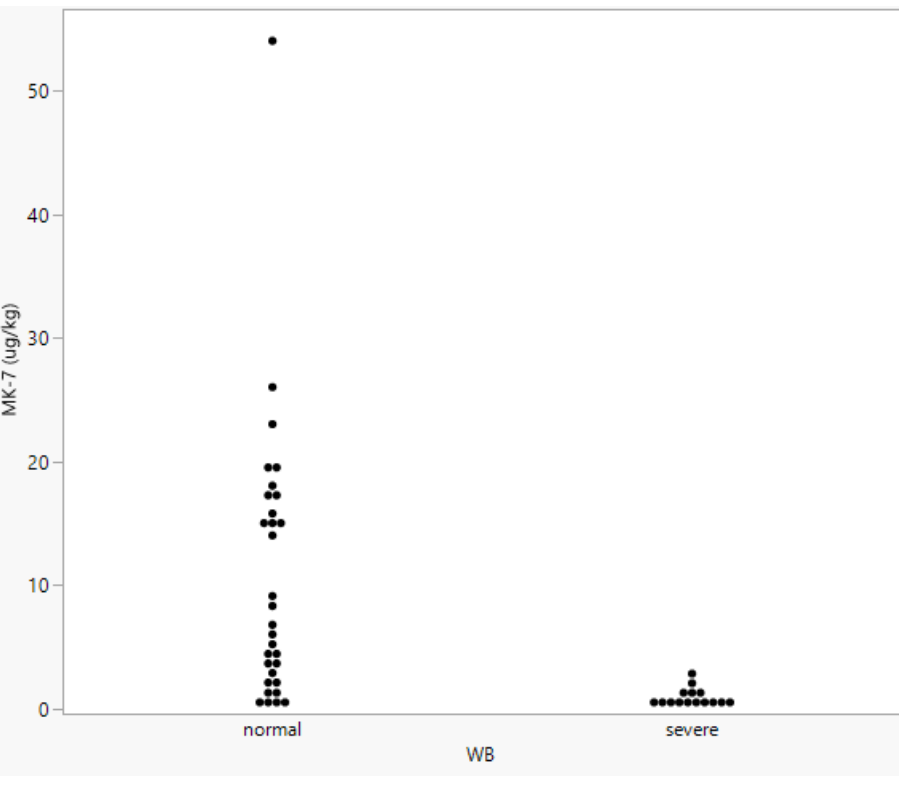
9 of 15 in concentration. Circles (•) indicate tha t birds had no White Striping (WS), squares ( ▪ ) moderate WS, and stars ( * ) severe WS.